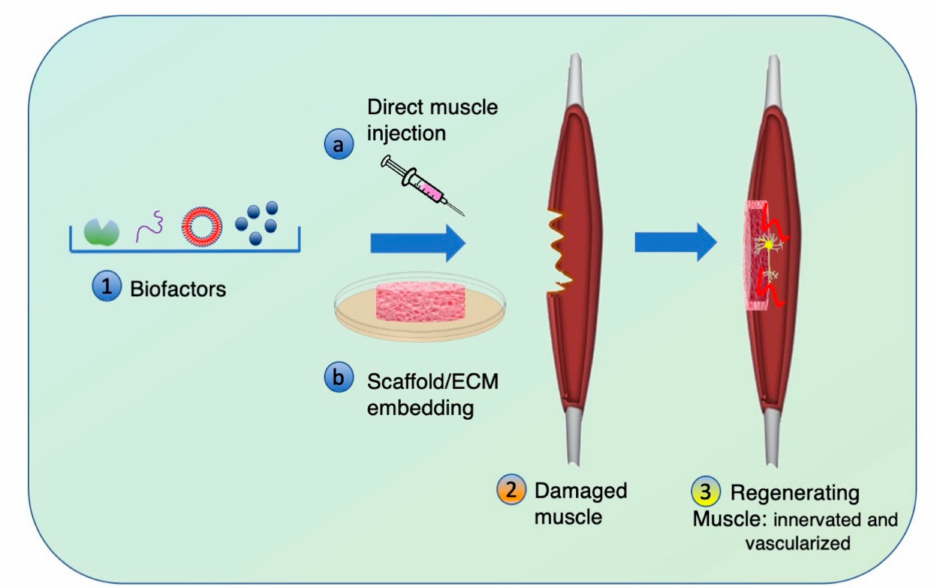
Figure 3. Biochemical stimuli to enhance muscle regeneration. (1) Growth factors, cytokines, small molecules, miRNA are biofactors known to improve the regeneration process (3) of a damaged muscle (2). The biofactors can be delivered to a damaged muscle by (a) direct injection or (b) previous embedding in a sca ff old. The factors can be also vehicled by plasmid or virus to enhance the release and possibly achieve innervated and vascularized